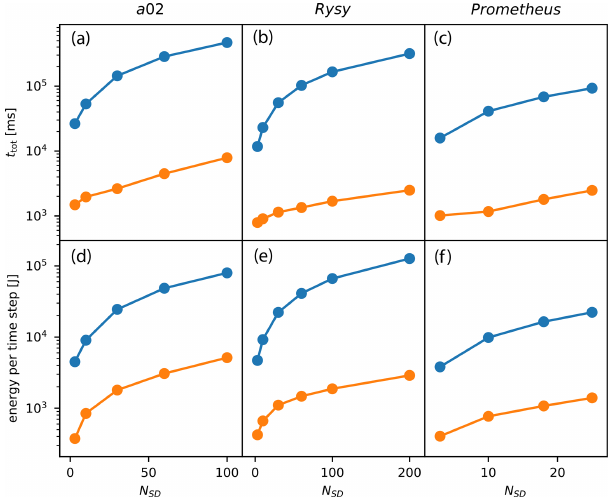
Figure 4. Wall time (a–c) and energy usage (d–f) per time step of CPU-only simulations (blue) and simulations utilizing both CPU and GPU (orange). In CPU-only simulations, energy usage is t tot × P CPU , where P CPU is the sum of thermal design power of all CPUs. In CPU + GPU simulations, energy usage is t tot P GPU , where P GPU is the sum of the thermal design power of all GPUs. P CPU and P GPU are listed in Table 1. Results are aver- aged over 100 time steps of UWLCM-SDM simulations on different single-node